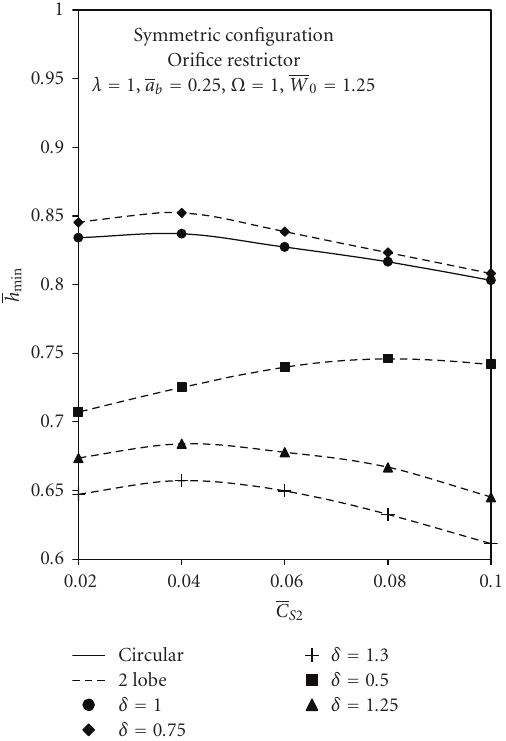
Figure 5: Variation of fluid film thickness ( h